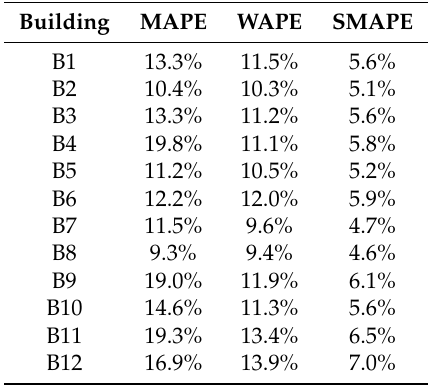
Table 3. Prediction error for each building: random forest regression model, time frame: 5–10 p.m.